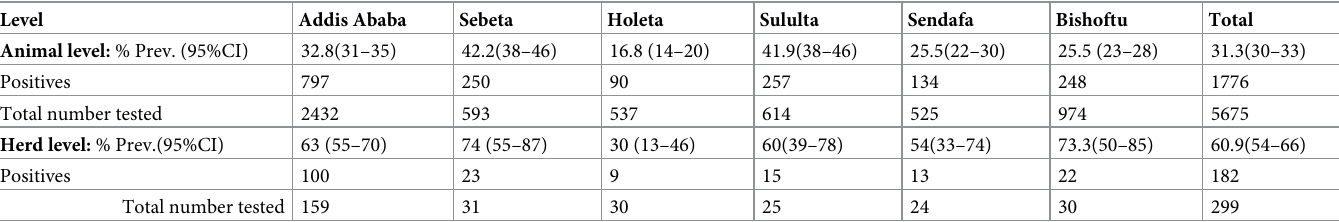
The average within-herd prevalence is heavily skewed by a relatively small proportion of extremely high prevalence herds (illustrated by Fig 2). Within-herd prevalence is multi-modal with the majority of small and medium herds having a prevalence less than the population average. The population mean 31.5% was higher compared to the median 10%, thus indicating a positive skewedness and that a higher proportion of herds (67.9%) had a within herd preva- lence less than the population average. Although the average within-herd prevalence does not demonstrate a strong herd-size dependence, there is a marked difference in the distribution Table 2. Animal and herd level bTB prevalence for 299 dairy herds in the six study areas.